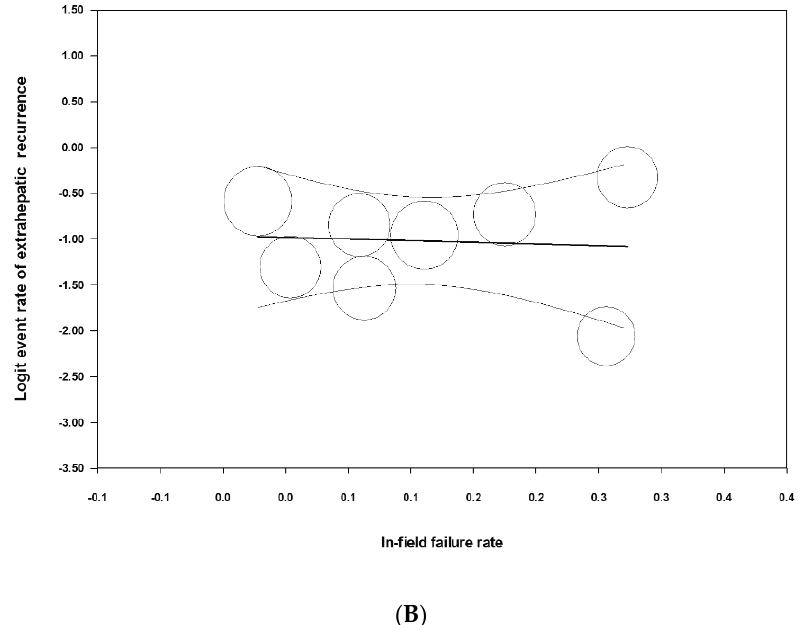
Figure 2. Scatterplots of meta-regression analyses: ( A ) comparison between the logit event rates of intrahepatic recurrence and in-field failure ( p = 0.6341); ( B ) comparison between the logit event rates of intrahepatic recurrence and extrahepatic failure ( p = 0.8529).